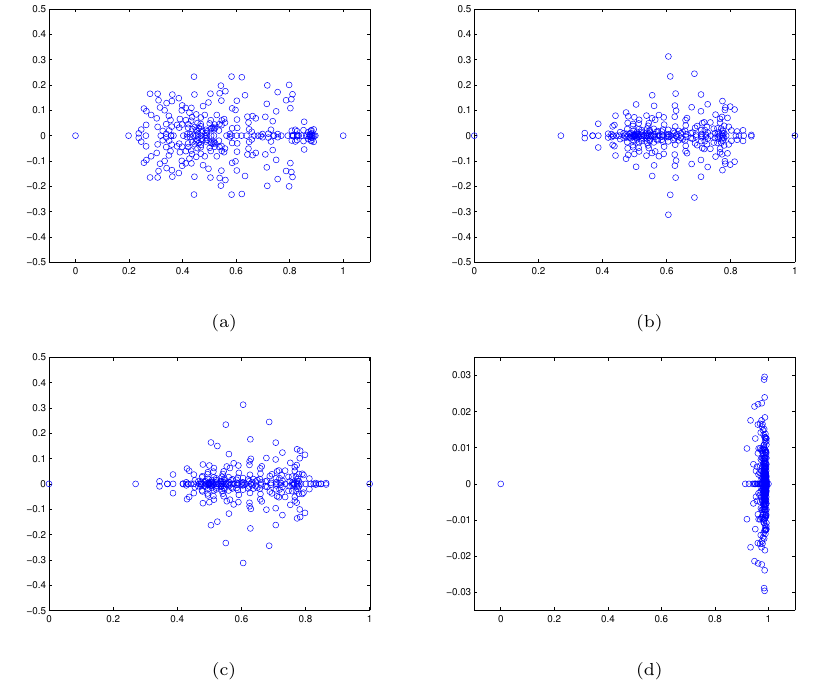
Figure 1. Spectrum of the preconditioned steady Oseen matrix, Q2-Q1 FEM, 32 × 32 uniform grid, ν = 0 . 01, and experimentally optimal τ,α,γ . (a): the RDF, (b): the SPP, (c): the MAL, (d): the